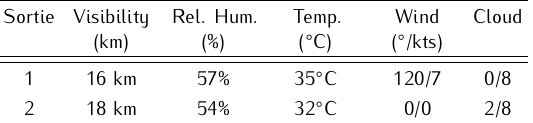
Table 22. Meteorological data relative to propagation flight